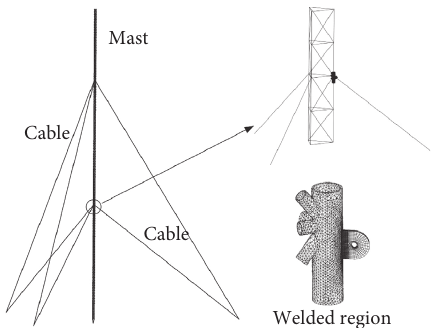
Figure 3: Multiscale finite element model of the guyed mast